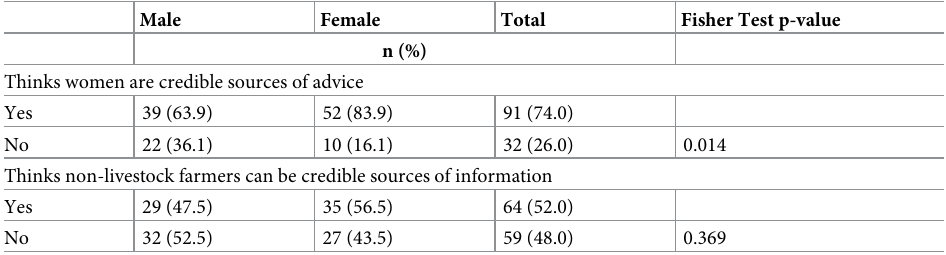
Table 6. Attitudes toward source of information among respondents in Nyagatare District, Rwanda (N =